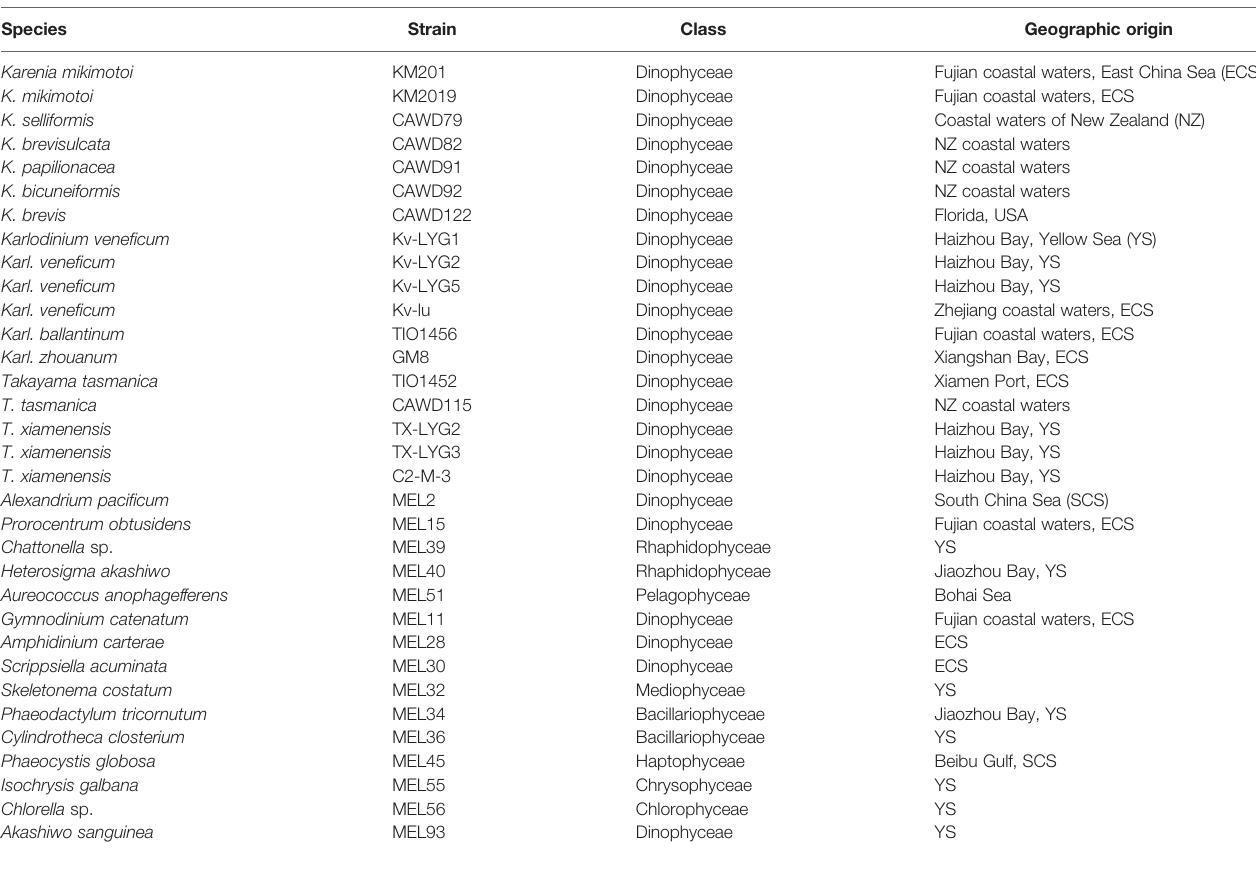
TABLE 1 | Microalgal strains used in this study. Species